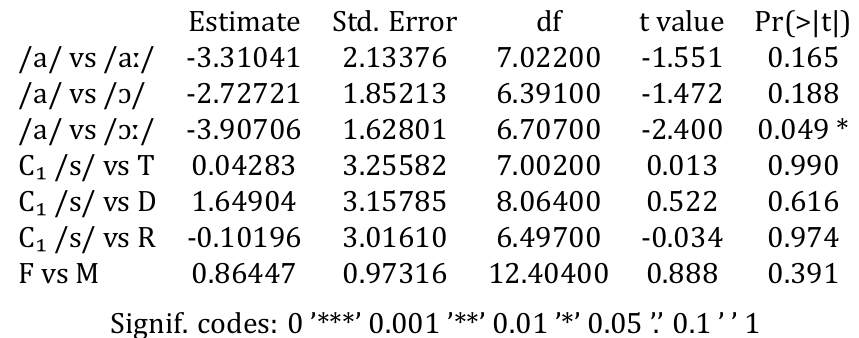
Table A.16: Breathiness duration (ms) prior to C₂ /s/ as a dependent variable